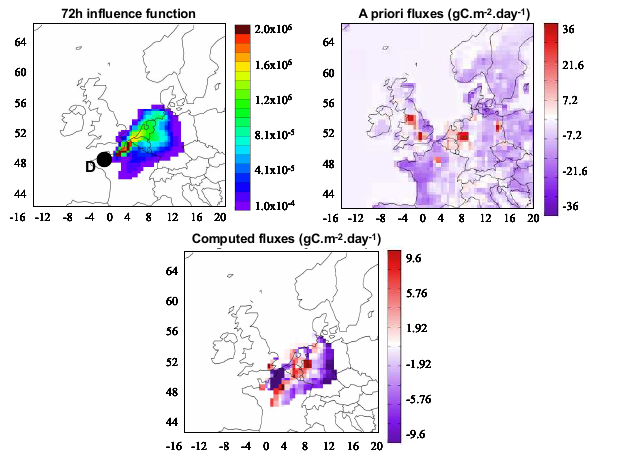
Fig. 8. Top left panel: LMDZt influence function (IF) calculated for 3 days backwards from the observing point (dark circle) cor- responding to event D in Fig. 7a. Top right panel: a priori fluxes (anthropogenic, biospheric and oceanic), summed and averaged for the period from 21 May 2001, 12:00 UTC to 25 May 2001, 12:00 UTC. Low panel: Weighted fluxes contributing to the CO 2 signal recorded at the observing point. Flux units are in gCm − 2 day − 1 .